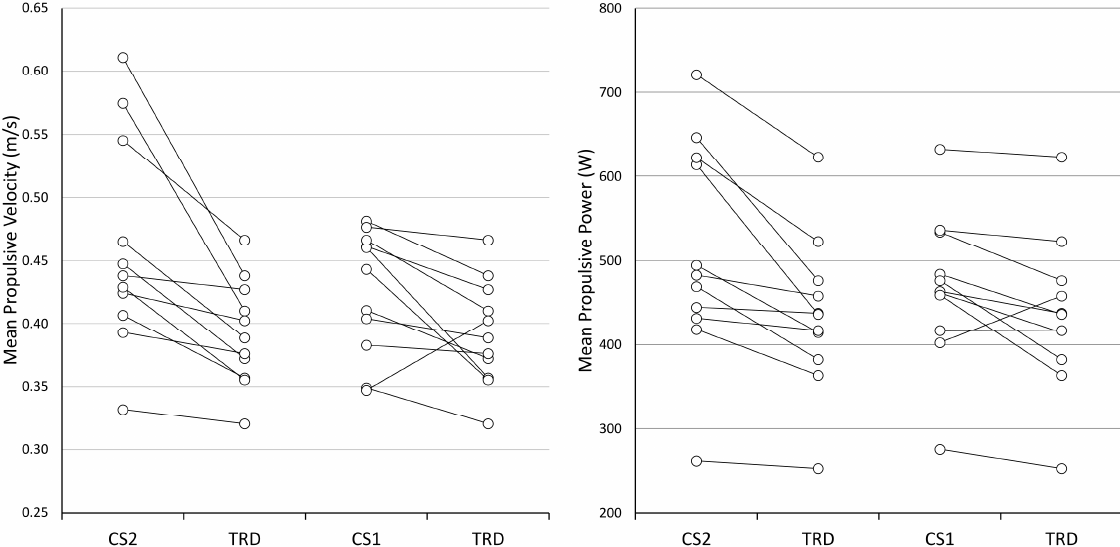
Figure 3. Individual measures for Mean Propulsive Velocity ( left ) and Mean Propulsive Power ( right ) for Protocols CS2 (Cluster 2), CS1 (Cluster 1), and TRD (Traditional). Data are expressed as mean value for protocol.